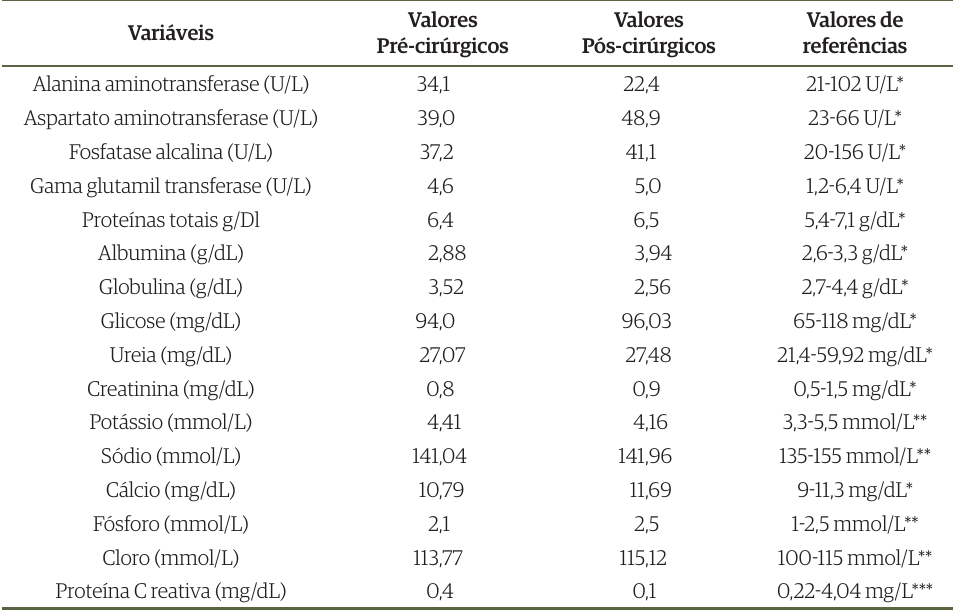
Tabela 2. Valores bioquímicos, eletrolíticos e de proteína C reativa de um cão macho, sem raça definida, 8 anos, com hemangiossarcoma cutâneo, atendido no Hospital Veterinário da Universidade Federal de Campina Grande,